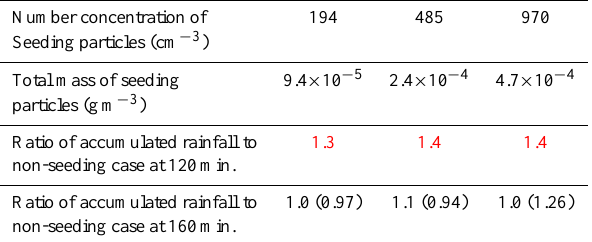
Table 9. Ratios of seeded-case to non-seeded-case accumulated sur- face rainfall averaged over the domain at 120 and 160min. Seeding of stratiform cloud is carried out with flare particles (up to 25µm in radius). A ratio indicating an increase is colored red. Ratios of seeded-case to non-seeded-case (180cm − 3 ) cloud droplet number concentrations at 100m above the base of the cloud center at 62 min are shown in parentheses.